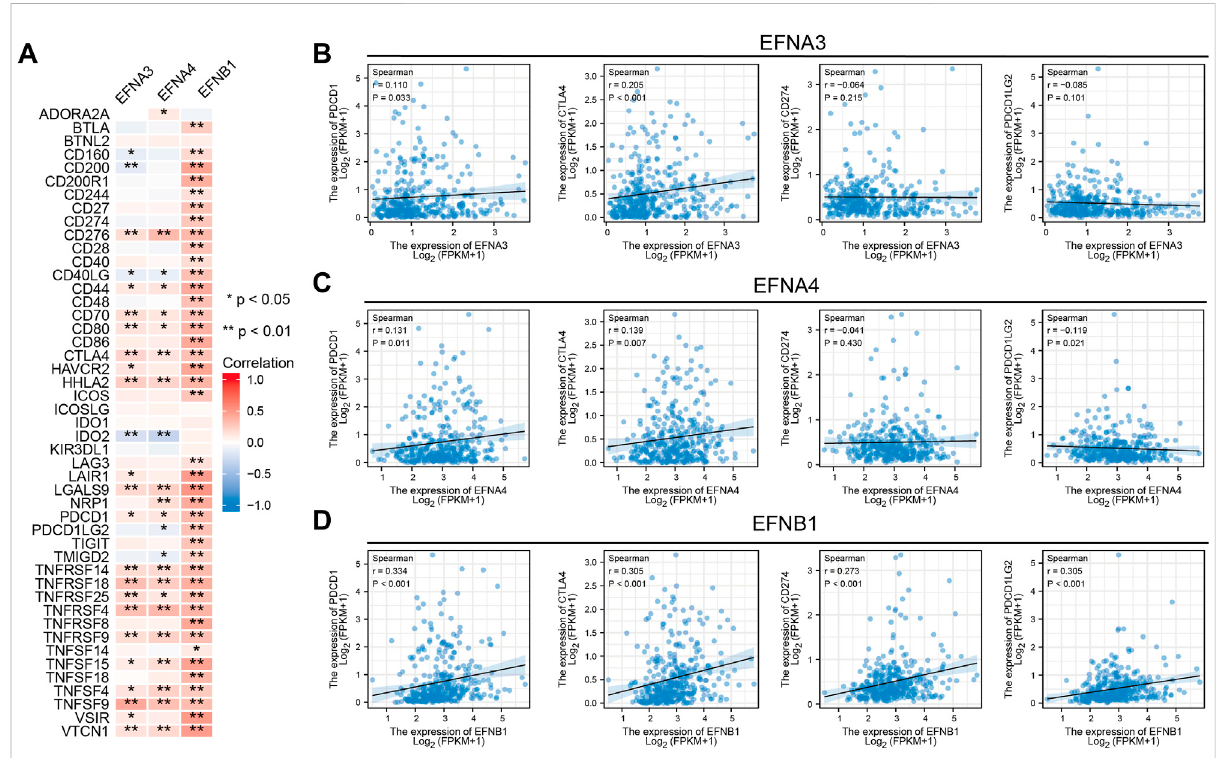
FIGURE 8 Relationship between signi fi cant prognostic ephrin members and immune checkpoint-related genes in HCC. (A) Heatmap displaying the coexpression relationship between prognosis-related ephrins and 47 immune checkpoint-related genes. (B – D) Scatterplots displaying the association of EFNA3 (B) , EFNA4 (C) , and EFNB1 (D) expression with four key immune checkpoint-related genes (PDCD1, CTLA4, CD274, and PDCD1LG2) with Spearman correlation analysis. r: Spearman ’ s rank coef fi cient; * p < 0.05; ** p <